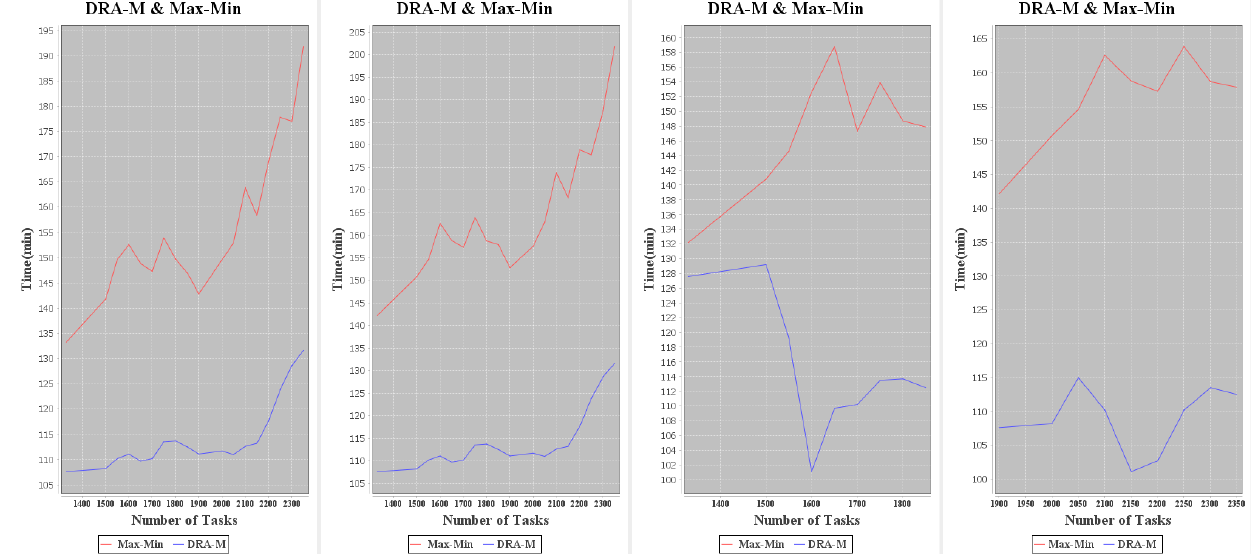
Figure 9. Time comparison of Max-Min and DRA-M